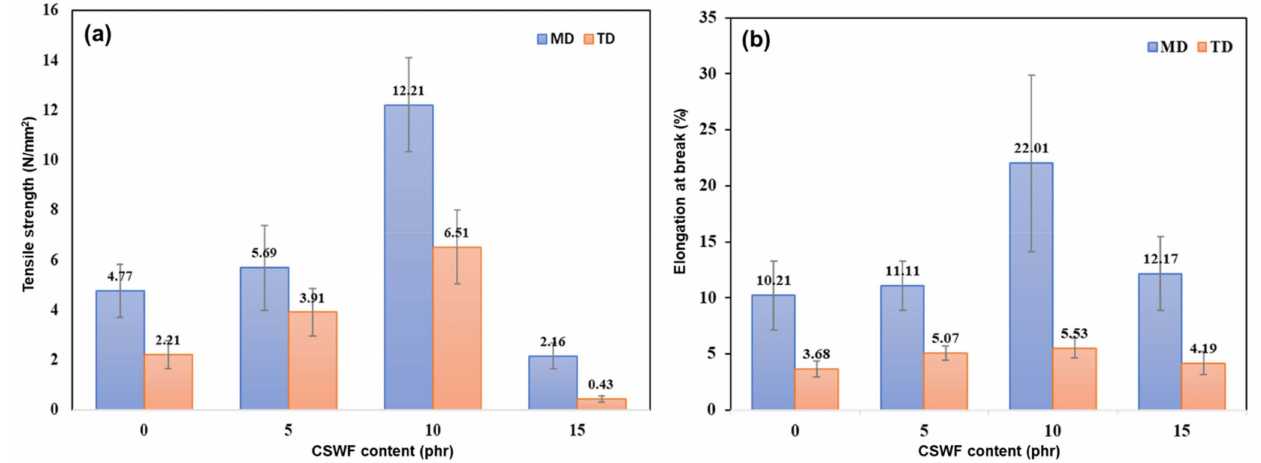
Figure 5. Mechanical properties of PBS/CSWF composite films—( a ) tensile strength and ( b ) elonga- tion at